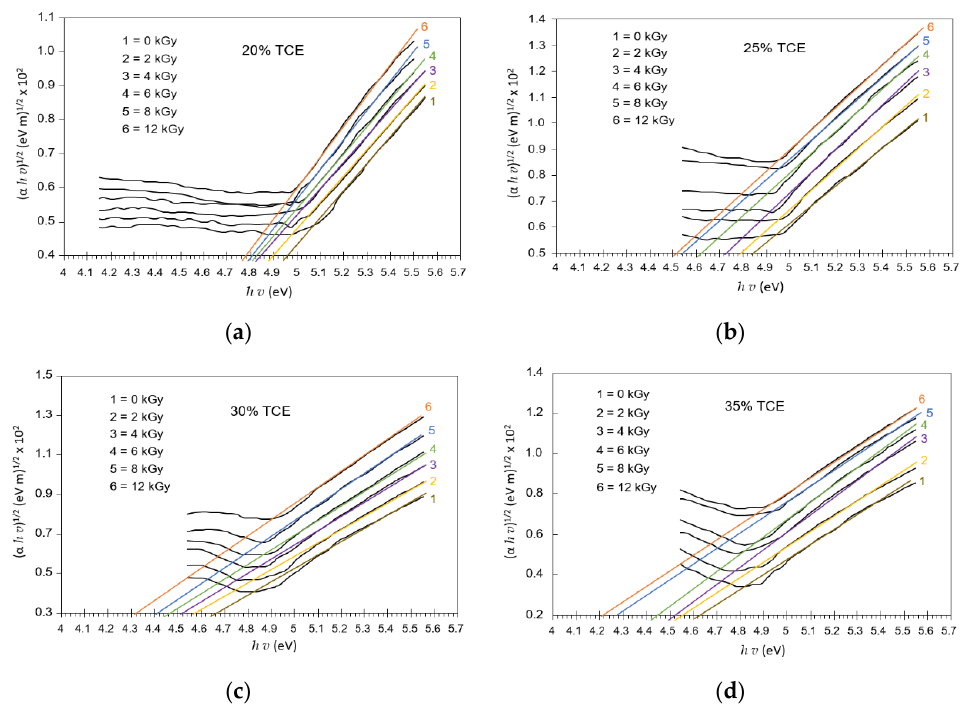
Figure 13. Variation of indirect allowed transition ( α hv ) 1/2 vs. hv at various doses PVA-TCE-CT polymer films at; ( a ) 20%; ( b ) 25%; ( c ) 30%; and ( d ) 35% TCE composition.